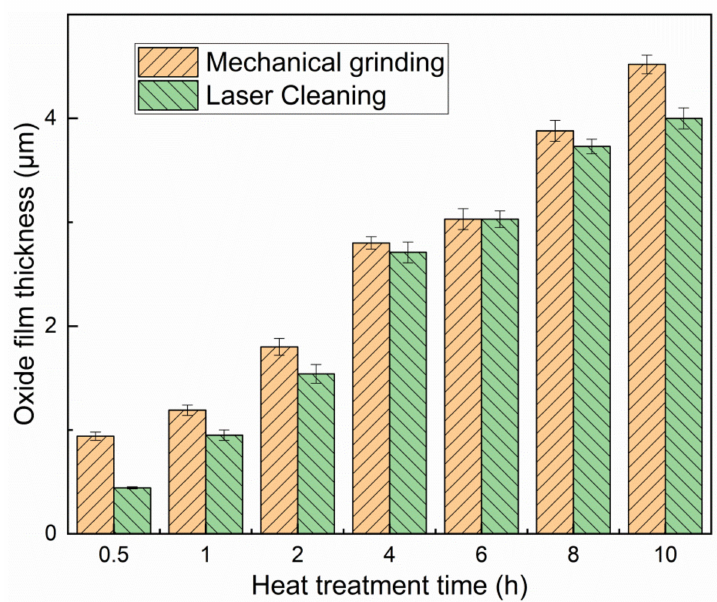
Figure 5. The thickness of the oxide film under different treatment methods and heating